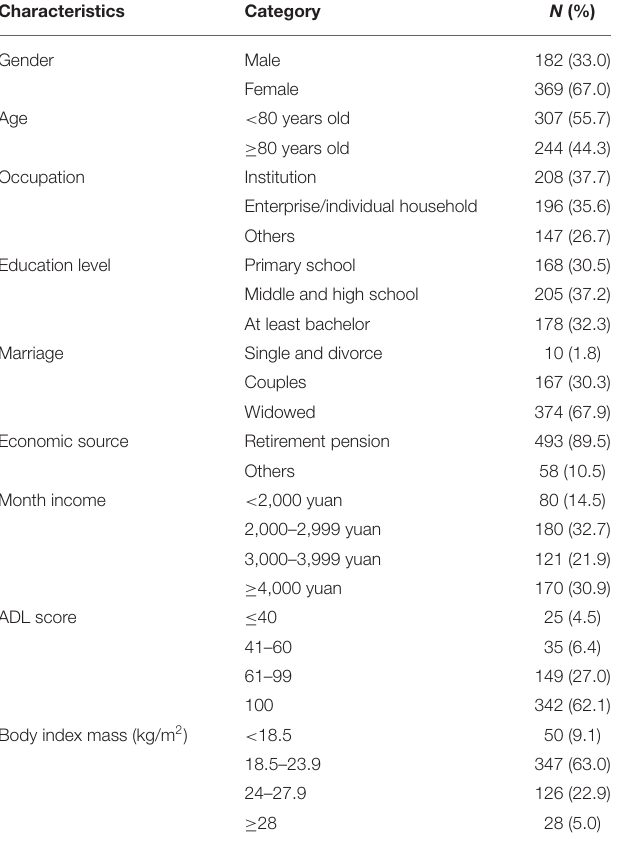
TABLE 2 | The constituent ratio of different UI among 134 UI patients.